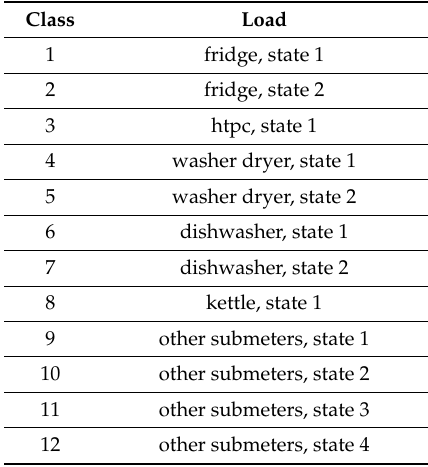
Table 2. Twelve load classes considered from the targeted electrical appliances in Table 1 and